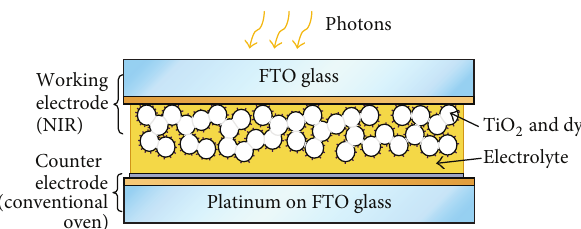
Figure 1: Schematic of the DSC architecture (electrode heating method is shown in